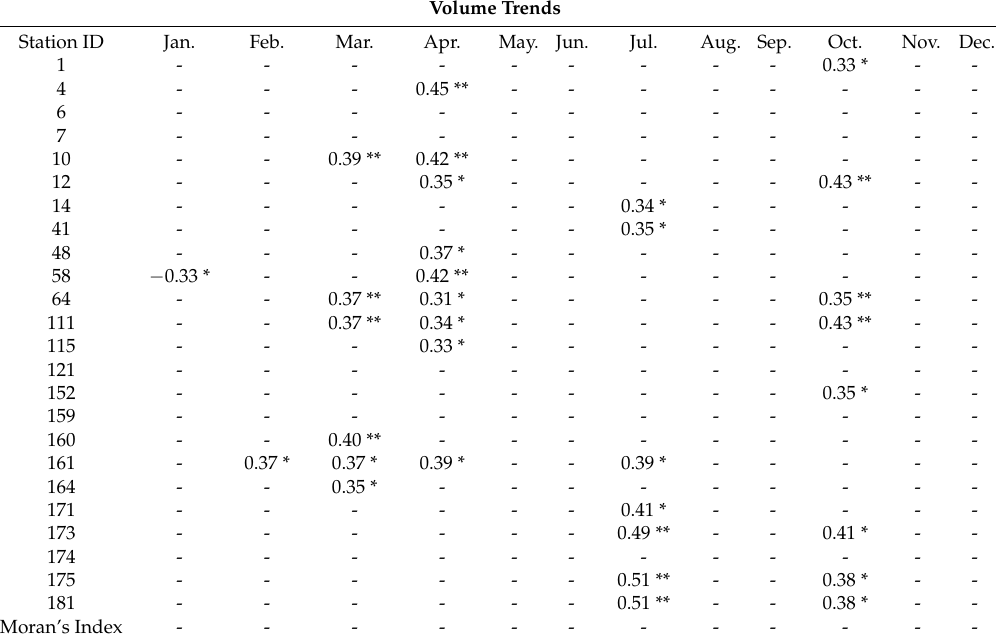
Table A3. Kendall’s Tau values for monthly precipitation